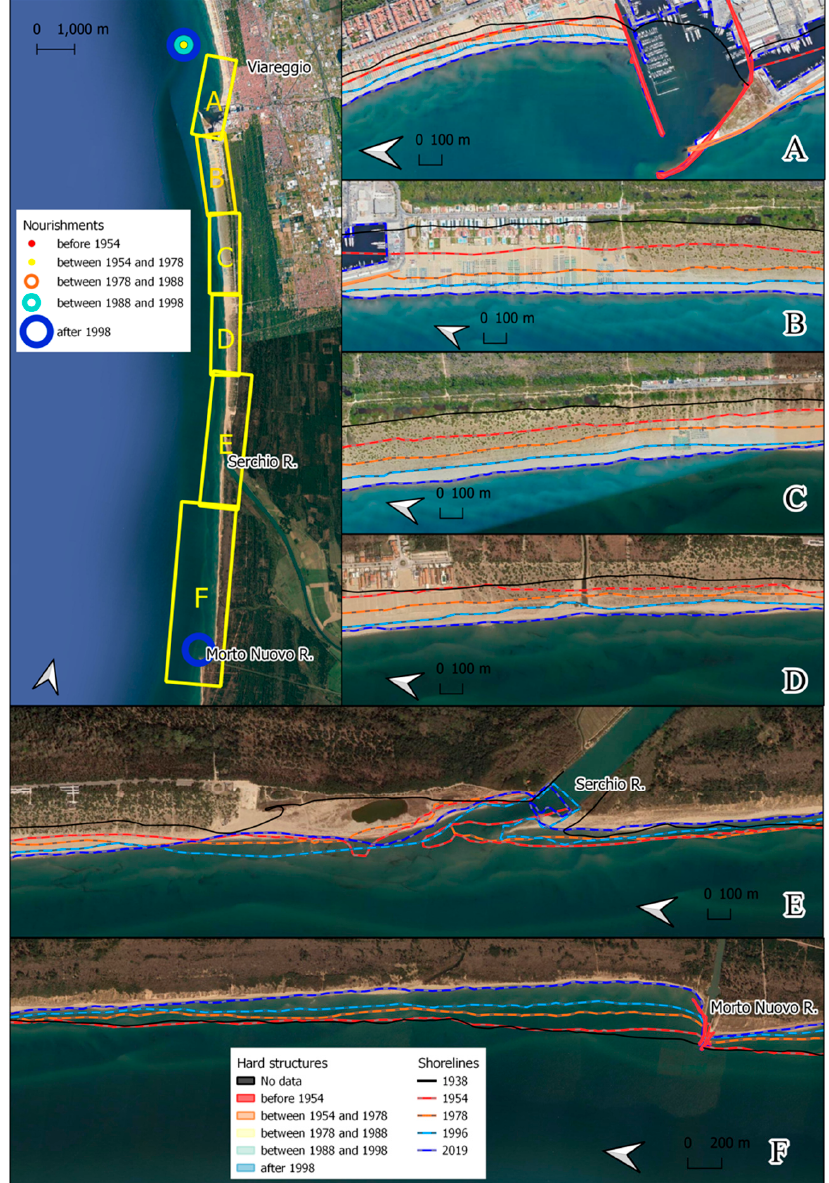
Figure 7. Identification of hard and soft operations along the sector comprised between Viareggio and the Morto Nuovo river mouth. Polygons represent the hard structures; dots represent the nourishments. The yellow frames in the top left panel correspond to the zoom in panels to the right and at the bottom. The background image has been retrieved from the Google Earth data-base.